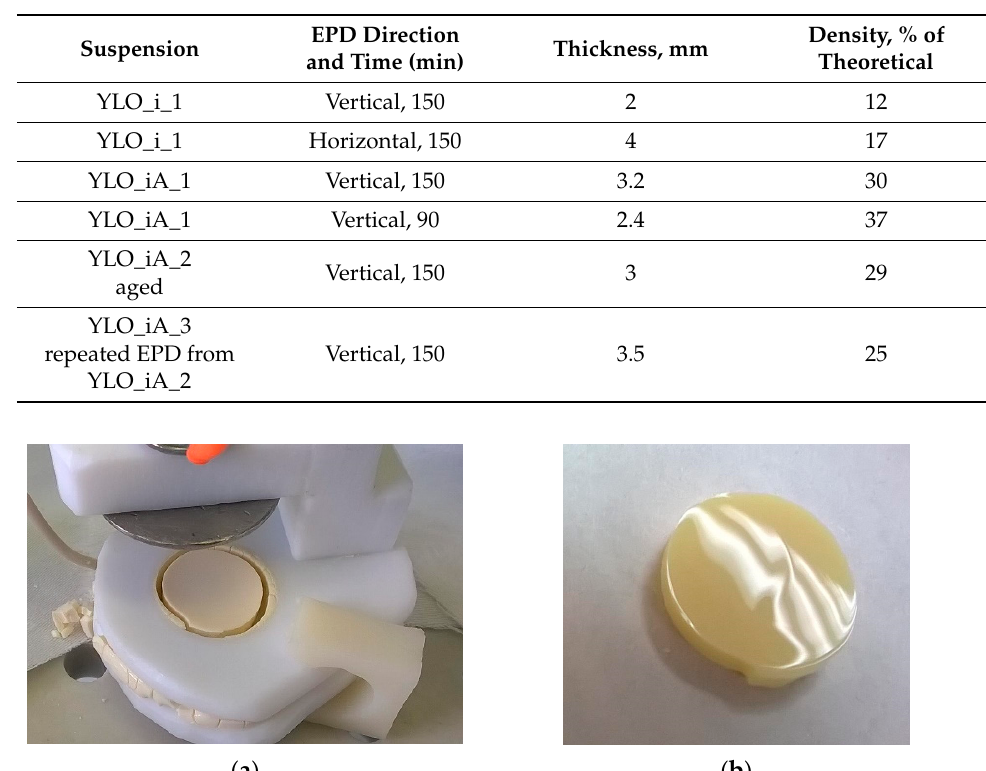
Table 2. Suspensions, EPD parameters, size and density of the green bodies.